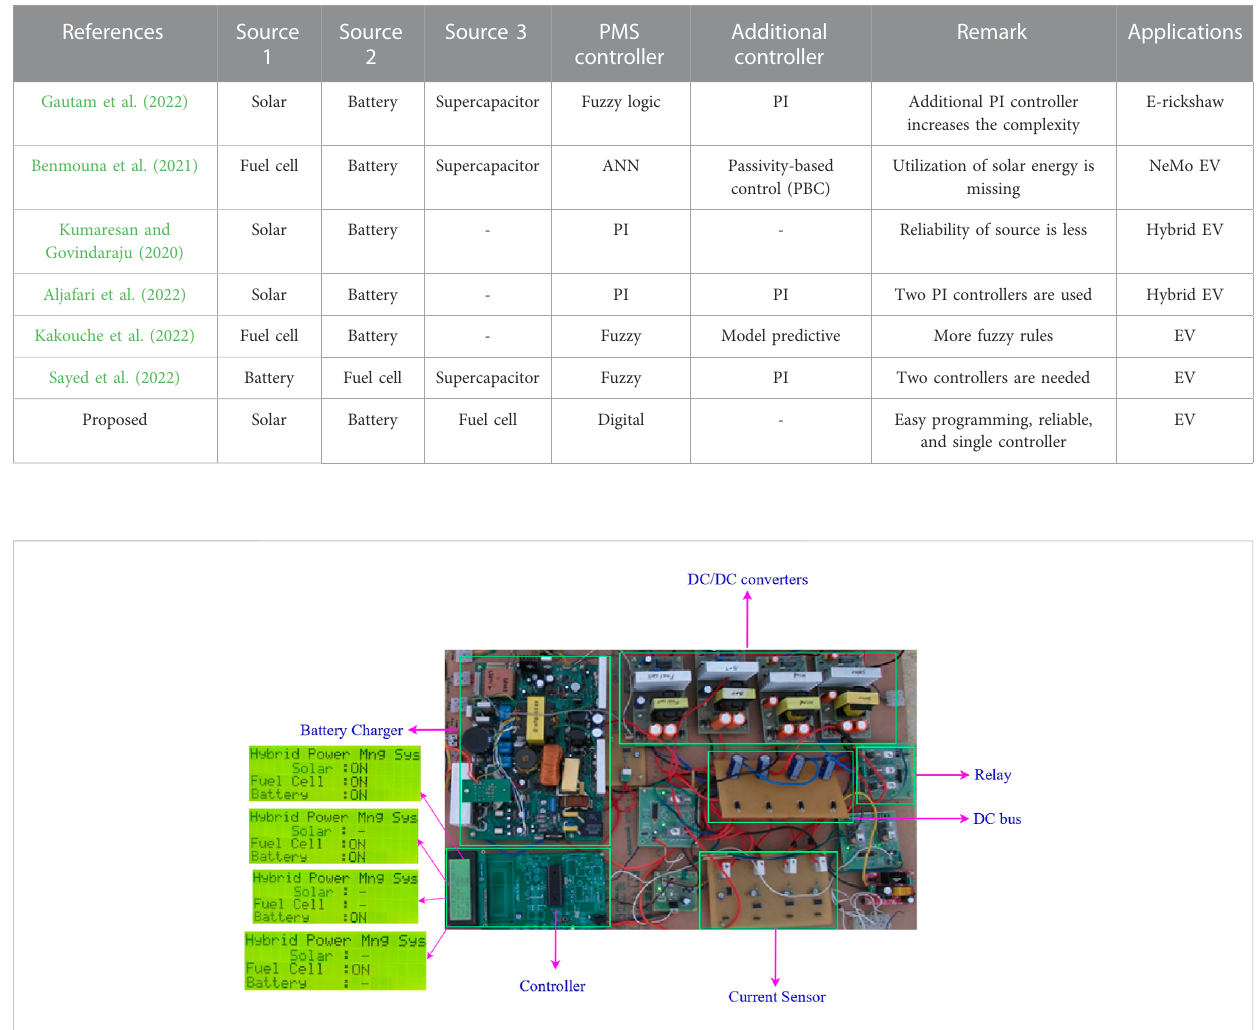
FIGURE 12 Hardware structure of proposed